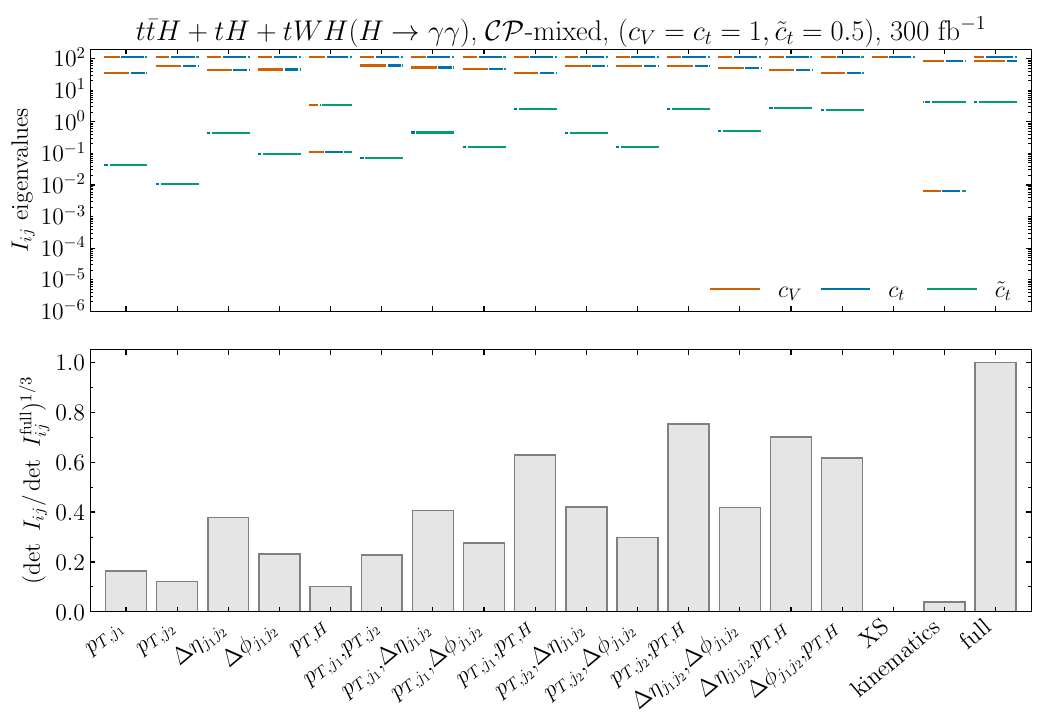
Figure 8 . Same as figure 7 but the Fisher information is evaluated for a CP -mixed benchmark point ( c V = c t = 1 , ˜ c t = 0 . 5